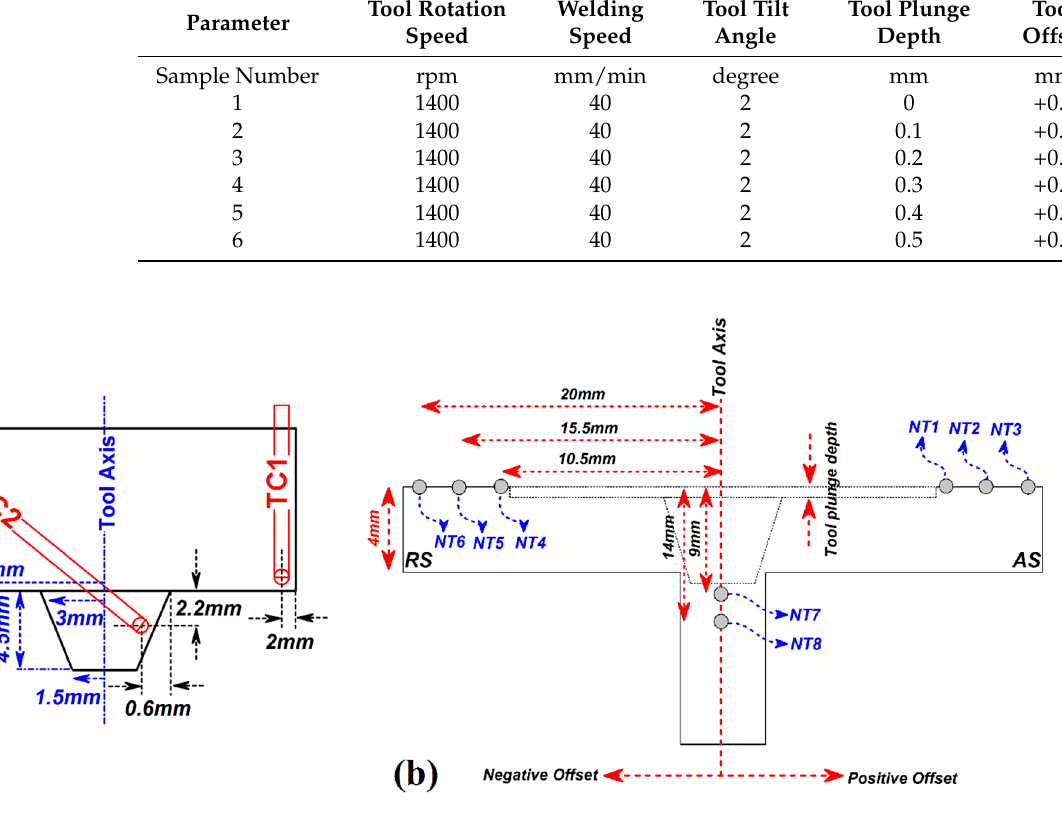
Figure 1. Schematic view of thermocouple position on ( a ) FSW tool and ( b ) skin and flange side.